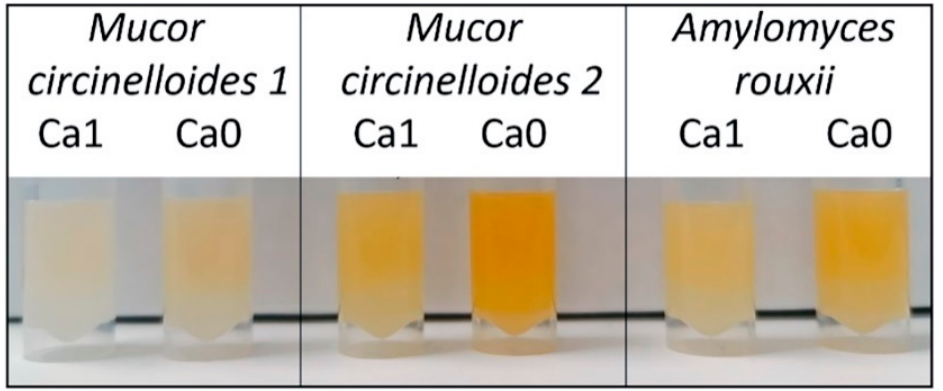
Figure 8. Fungal biomass grown in Pi0.5 media showing carotenoids content. A visibly higher content of carotenoids is observed in biomass grown in Ca-lacking media. Carotenoid production for M. circinelloides has been reported previously [39,40], with the main factors triggering carotenoid production being light, temperature, and aeration [41,42]. To the authors’ knowledge, this is the first indication of the triggering effect of calcium deficiency on carotenoid production. Since assessment of